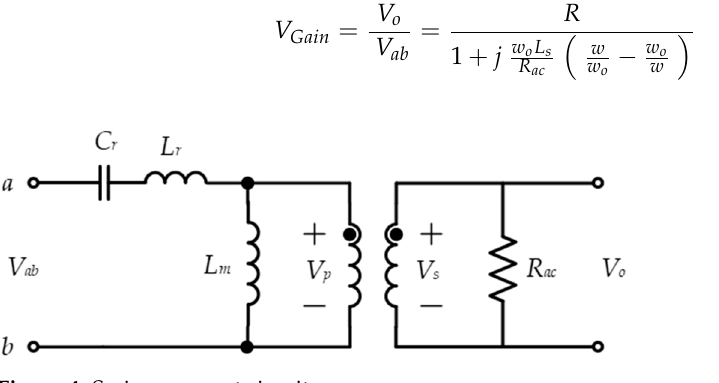
Figure 4. Series resonant circuit.